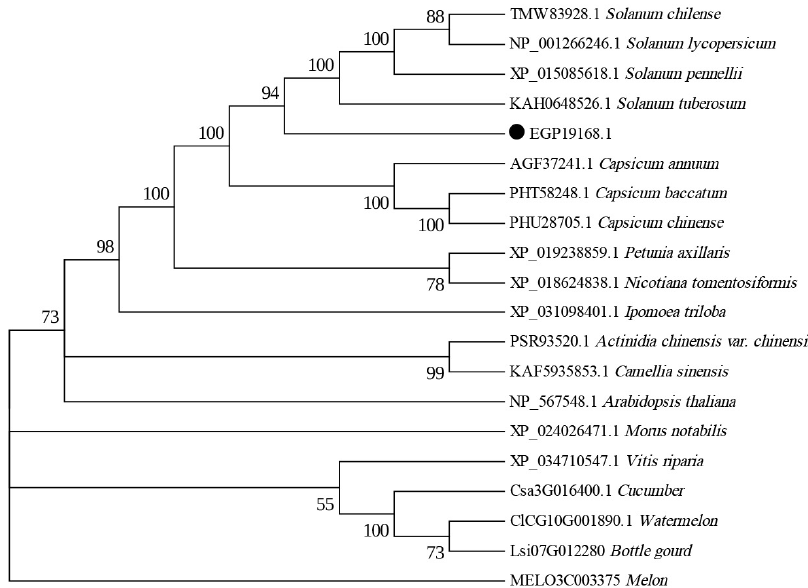
Figure 6. Phylogenetic analysis. Phylogenetic tree of SmAPRR2 and its homologous proteins. Num- bers at the tree forks indicate bootstrap values.